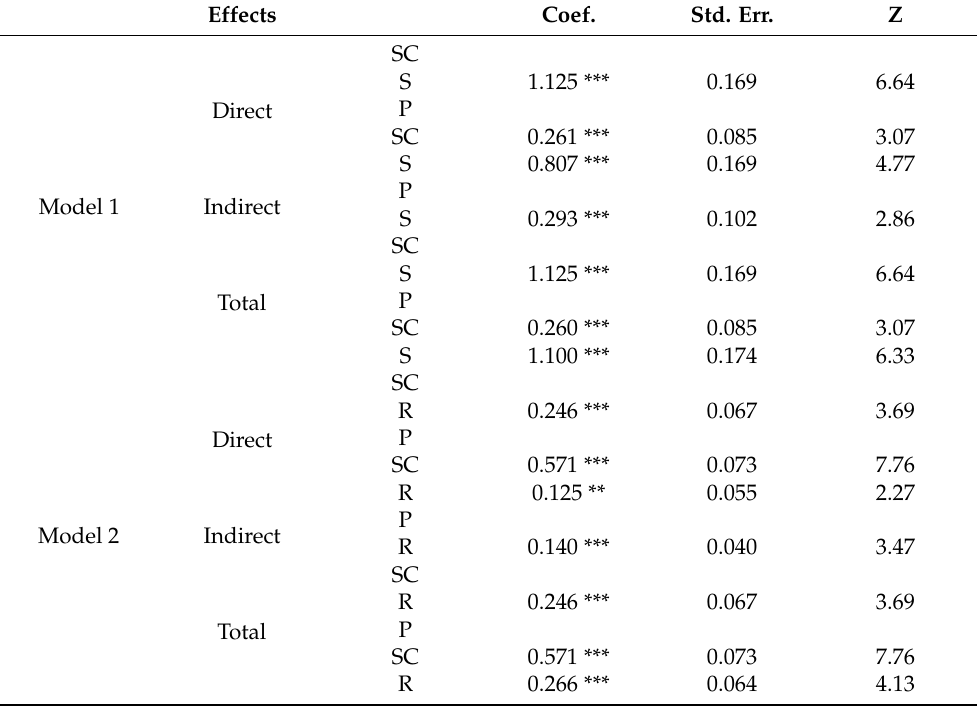
Table 6. Total, direct, and indirect effects in the models. Effects Coef. Std.